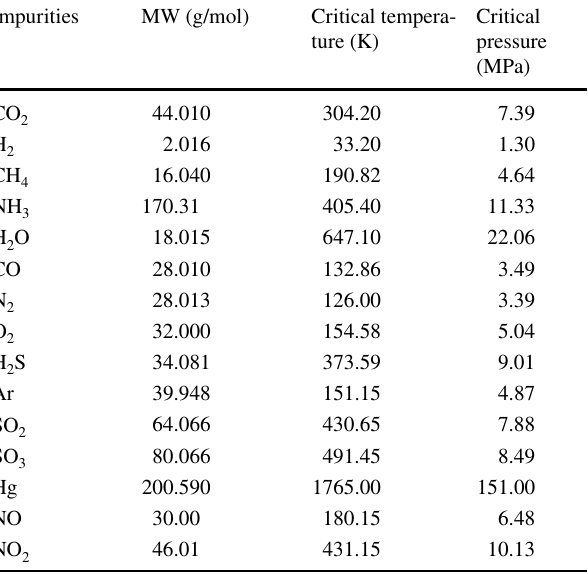
Table 3 Molecular Weight and Critical Properties for CO (Rumble et al. 2021; Wang 2015)